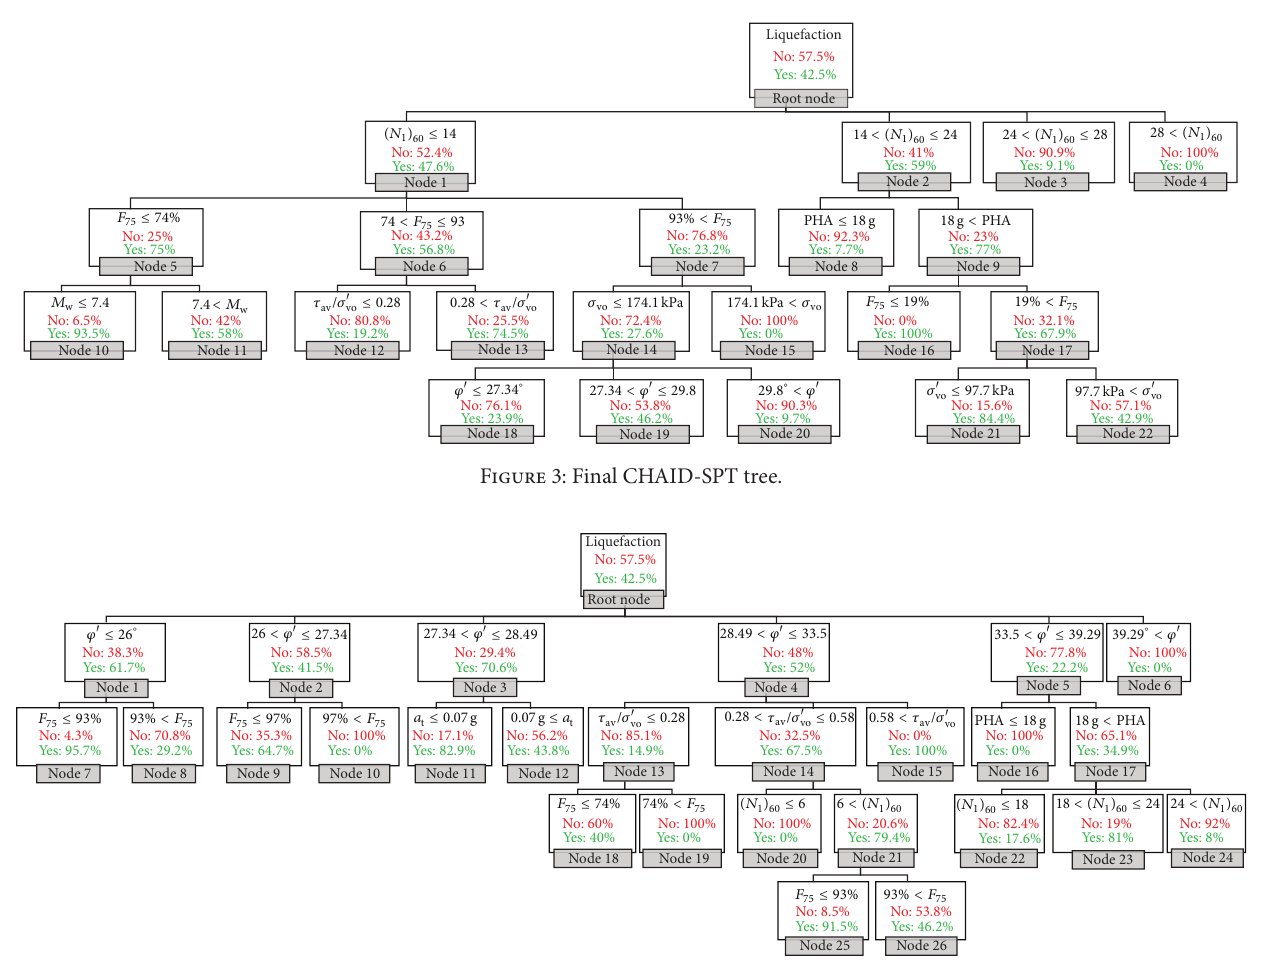
Figure 4: Final CHAID